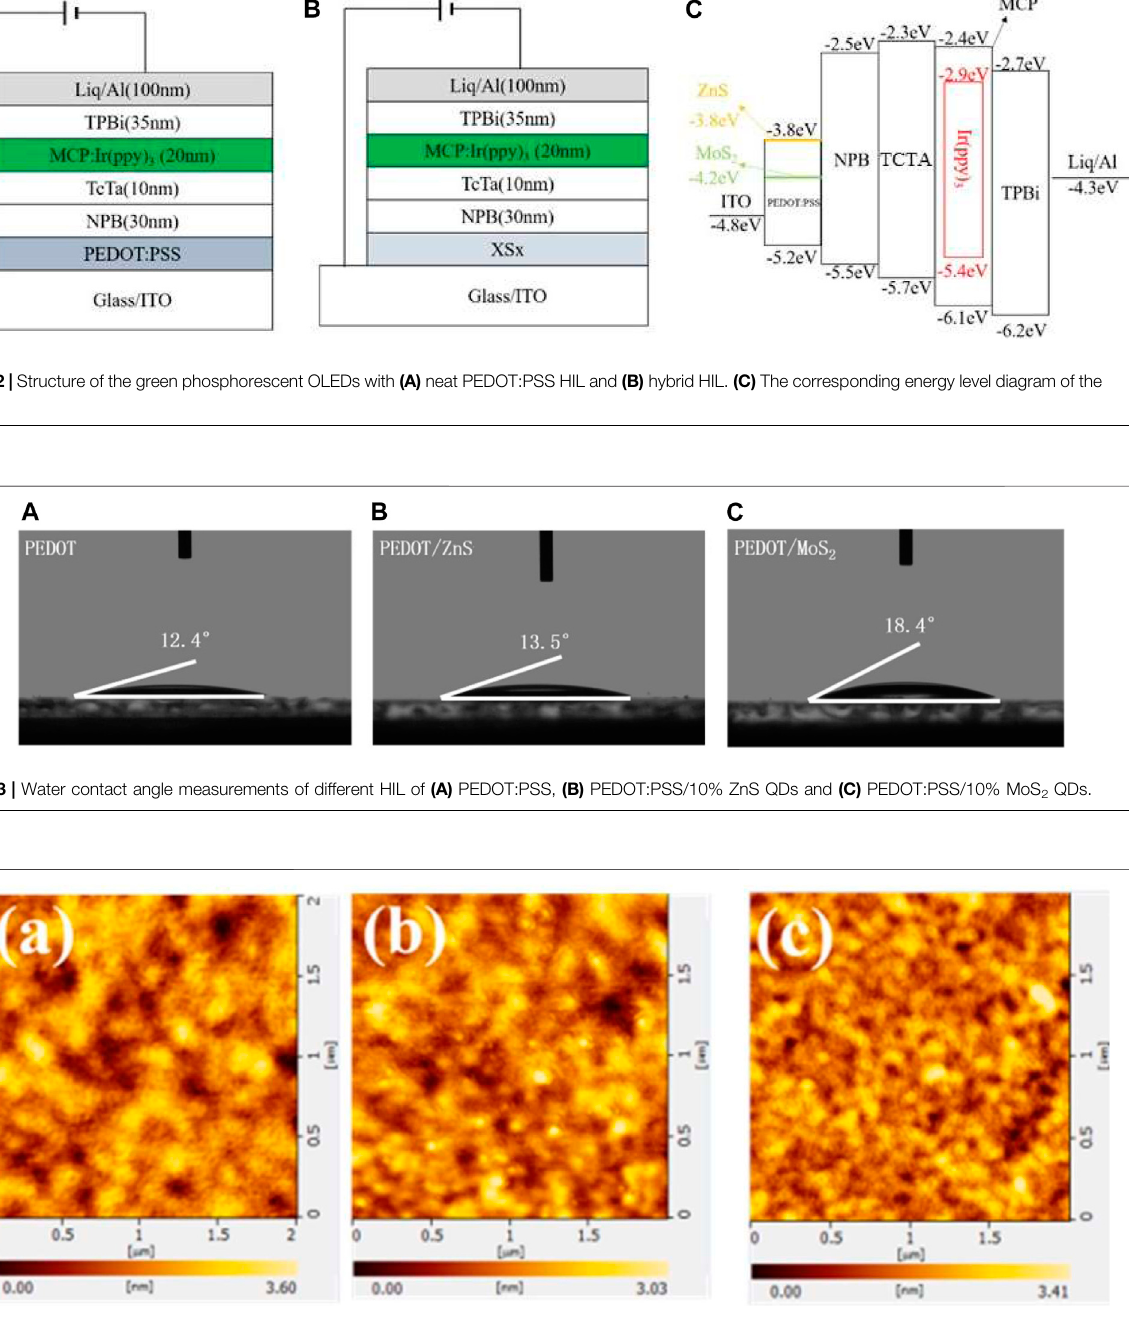
FIGURE 4 | AFM test of HILs of (A) PEDOT:PSS, (B) PEDOT:PSS/10%ZnS QDs and (C) PEDOT:PSS/10% MoS 2 QDs.